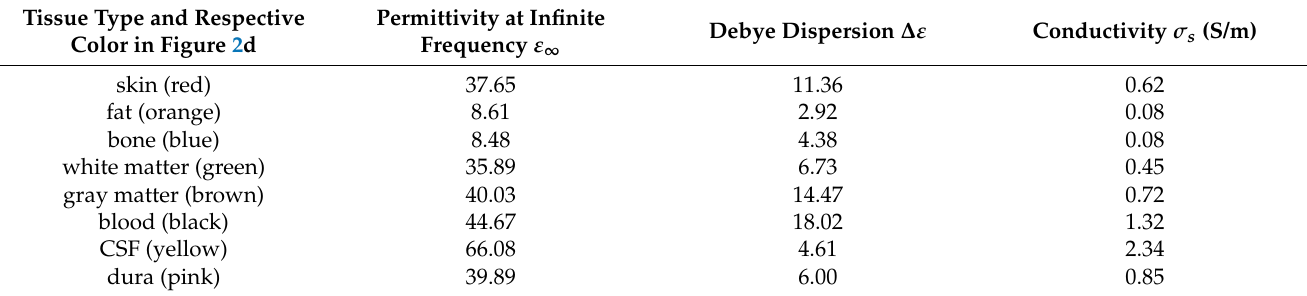
Table 2. Debye parameters for the Zubal head phantom.